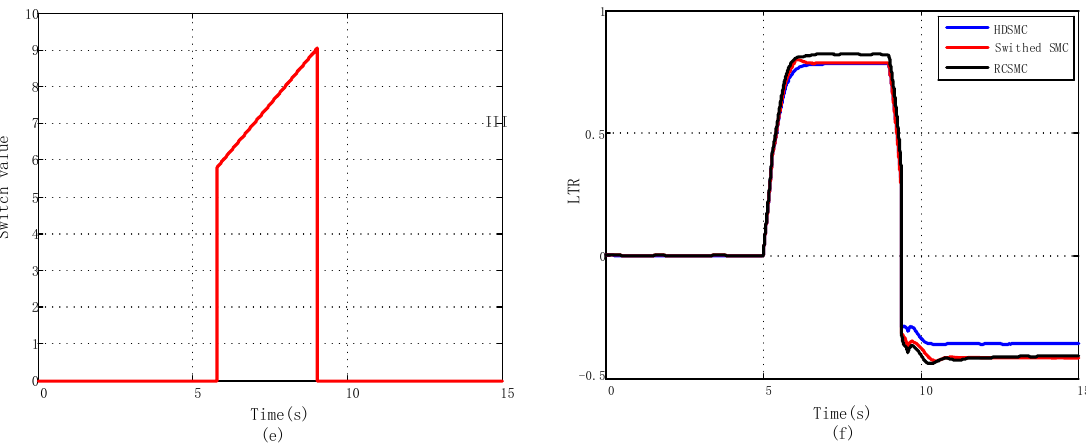
Figure 23. The rescue vehicle dynamic response based on the switch strategy under the bump road and the fishhook maneuver: ( a ) the vehicle body vertical acceleration in time domain; ( b ) the roll angle acceleration in time domain; ( c ) the vehicle body vertical acceleration in time domain in frequency domain; ( d ) the roll angle acceleration in frequency domain; ( e ) the switch value; ( f ) the LTR.